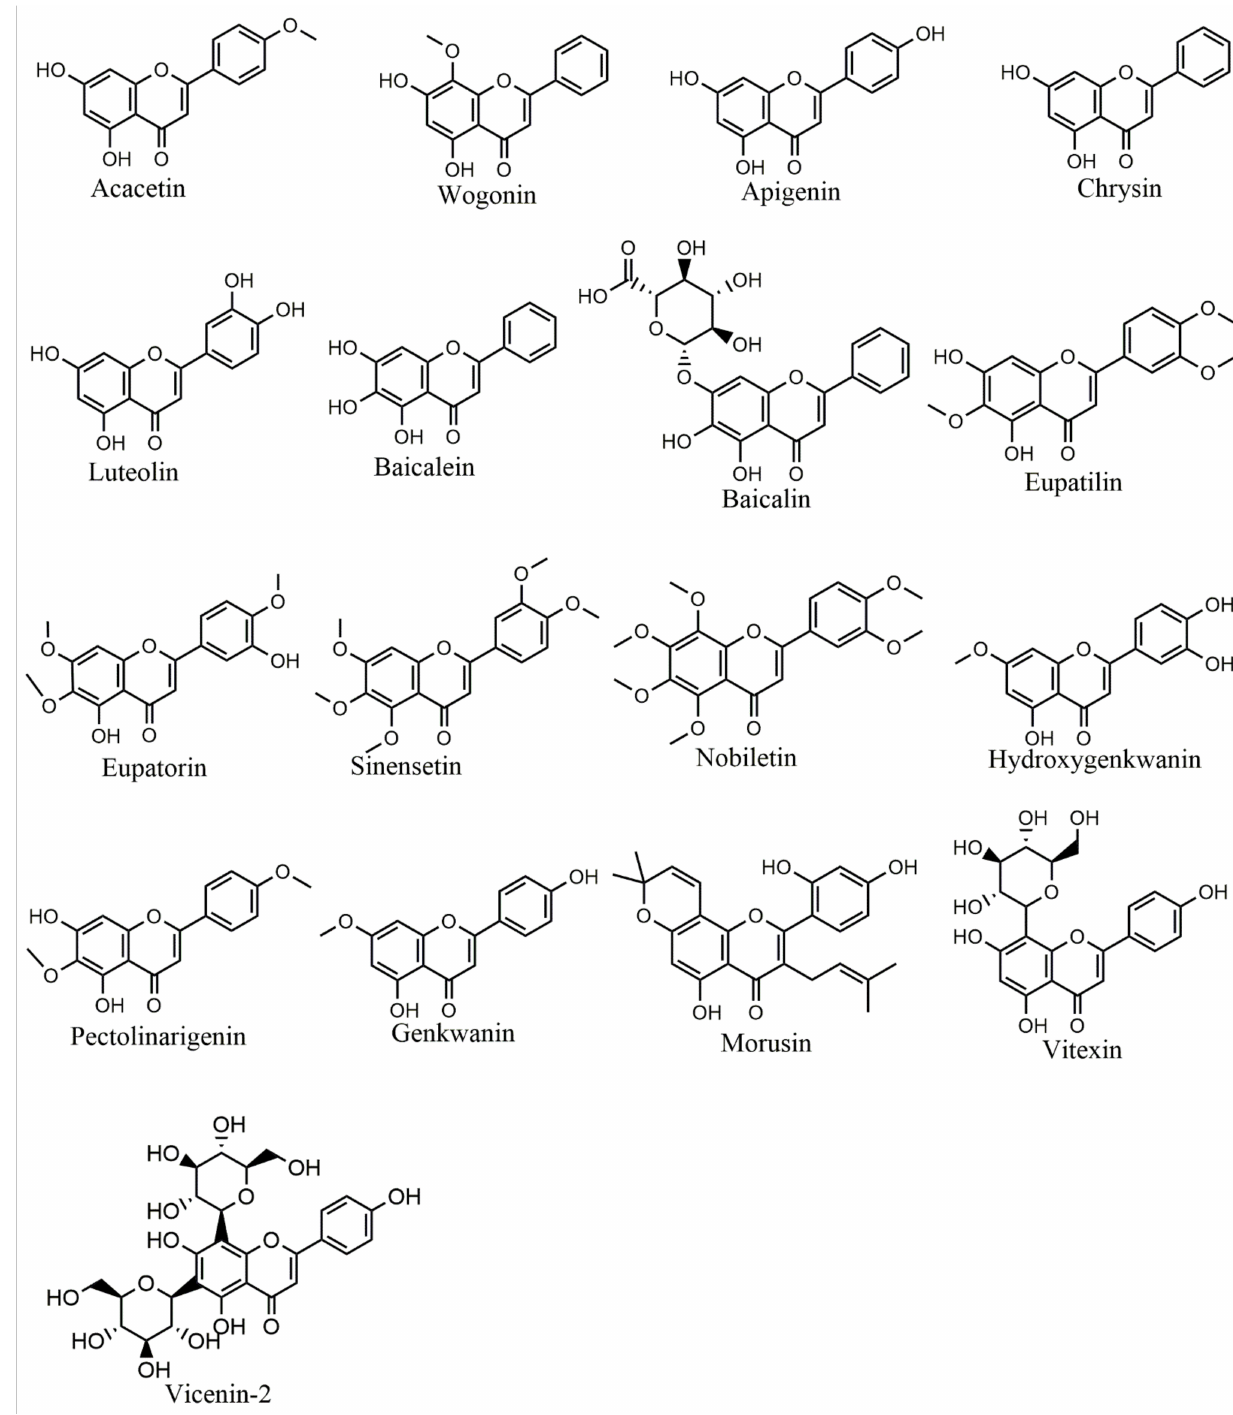
Figure 3. Selected chemical structures of flavones targeting Bcl-2 in the p53 pathway. In human lung cancer (A549) cell lines, apigenin (Figure 3) treatment caused cytotoxi- city by inducing DNA damage and decreasing cell viability in a dose-dependent manner. Apigenin induced apoptosis accompanied by the increase in the expression of Bax protein and inhibited Bcl-2 protein level leading to the disruption of mitochondrial membrane, which caused the release of cytochrome C and Endo G and induced the activation of cas- pases [40]. In hepatocellular carcinoma cells (HCC), chrysin (Figure 3) treatment increased the expression of pro-apoptotic agents such as p53, Bad, Bax and Bak proteins and